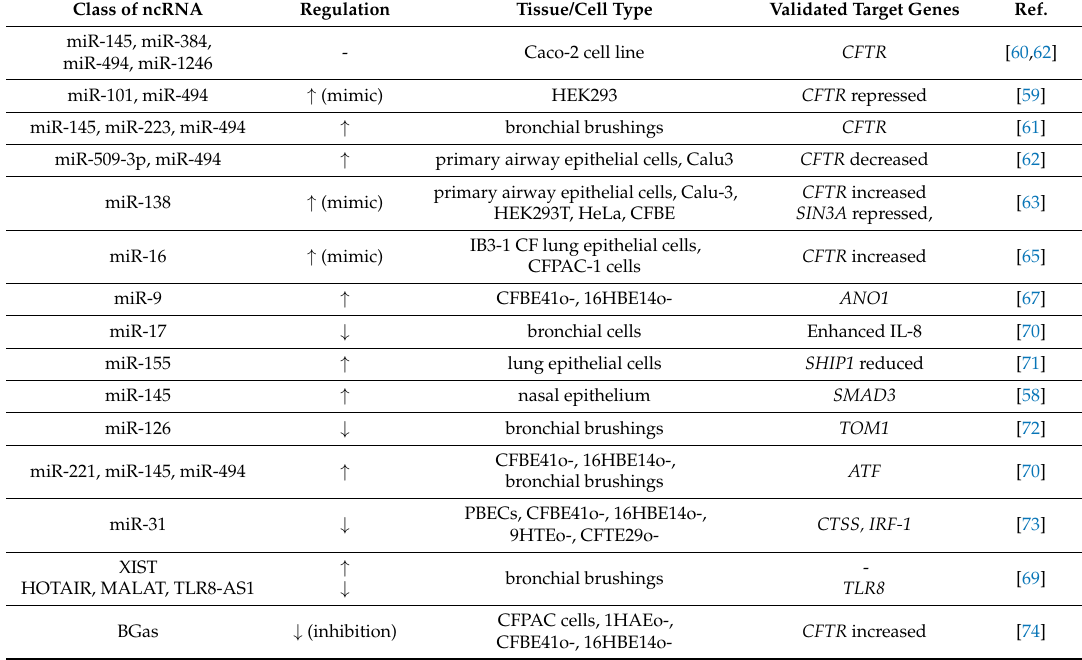
Table 2. NcRNAs in cystic